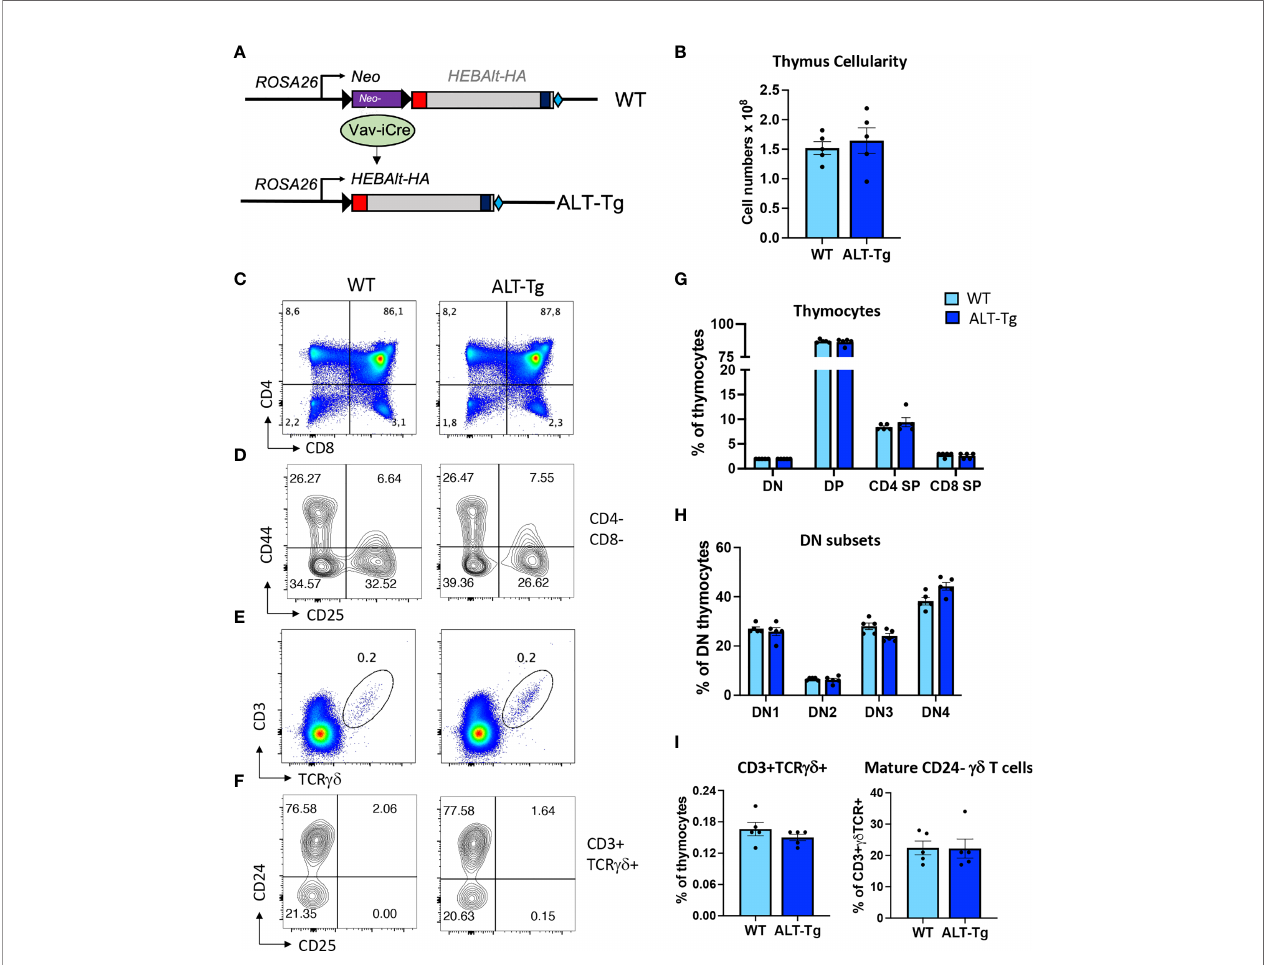
FIGURE 5 | Generation and characterization of conditional HEBAlt-HA transgenic (ALT-Tg)_ mice. (A) . An HA-tagged HEBAlt coding cassette was inserted into the ROSA26 locus downstream of a loxP-Neo-stop-loxP cassette in ES cells, giving rise to mice carrying an inducible HEBAlt-HA transgene. These mice were bred to Vav-iCre mice to generate WT (Vav-Cre-) and ALT-Tg (Vav-Cre+) littermates. (B – E) . Phenotype of thymic developmental subsets in WT and ALT-Tg mice by fl ow cytometry within total thymocytes (B, D) and and within DN cells (C, E) . (F – H) . Percentages of gd T cells within total thymocytes (F, H) , and percentages of immature (CD24+) and mature (CD24-) cells within the CD3+TCR gd + populations (G, H)